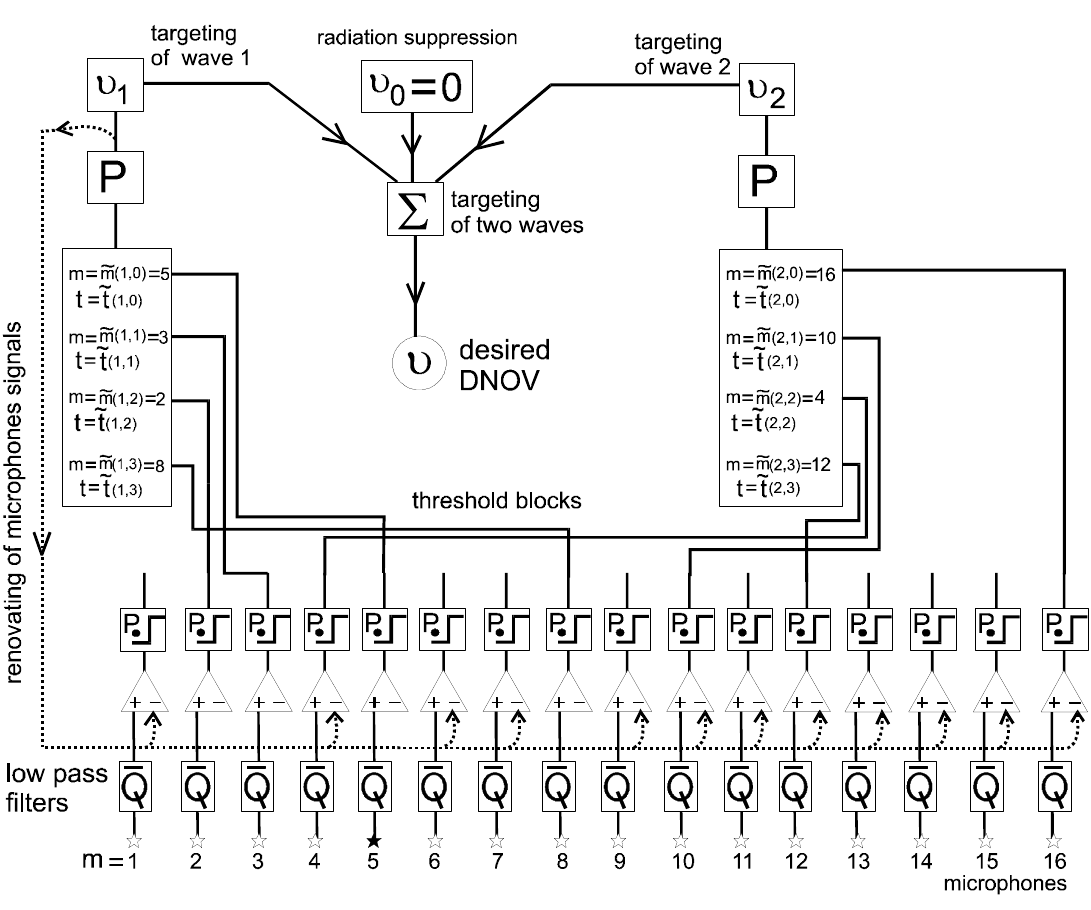
Figure 13. The example of forming groups of bearing for renovation of signals of microphones for 16 = PN